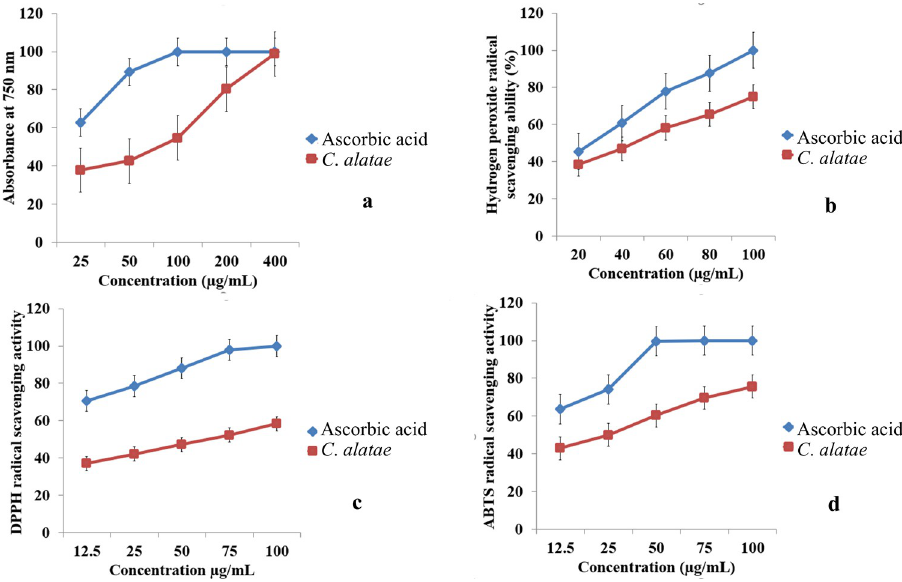
Fig 7. Antioxidant activity of endophytic culture extract (ethyl acetate fraction) of Colletotrichum alatae LCS1 and ascorbic acid as standard. a–Ferric reducing antioxidant power assay. b- Hydrogen peroxide radical scavenging ability. c- DPPH radical scavenging activity. d–ABTS radical scavenging assay Values on the graphs are the means ± Standard error (SE) of the three replicates.